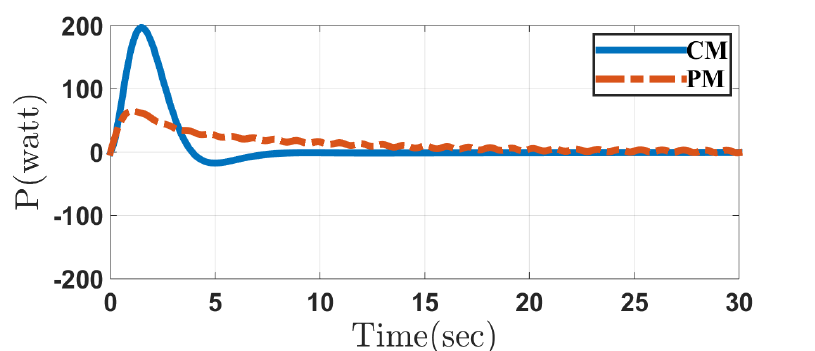
Figure 18. Input power of the wheels in the conventional method (CM) and the proposed method (PM) in Case